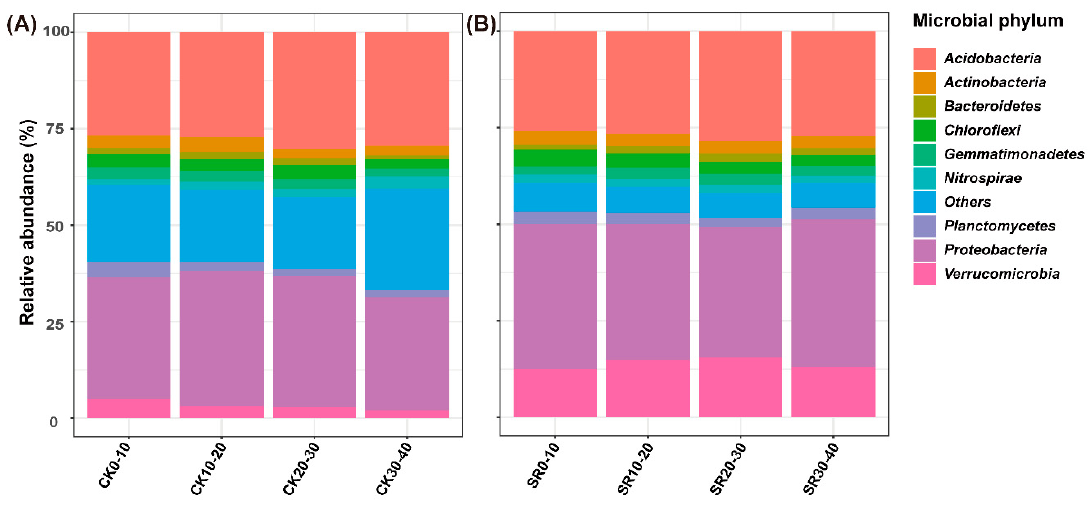
Figure 5. Relative abundances of the top 10 microbial phyla at different depths ( A ) in the sugarcane straw retention (SR) and control (CK) treatments ( B ). “Others” refers to those identified phyla that were beyond the top 10 phyla. CK, control; and SR, sugarcane straw retention.